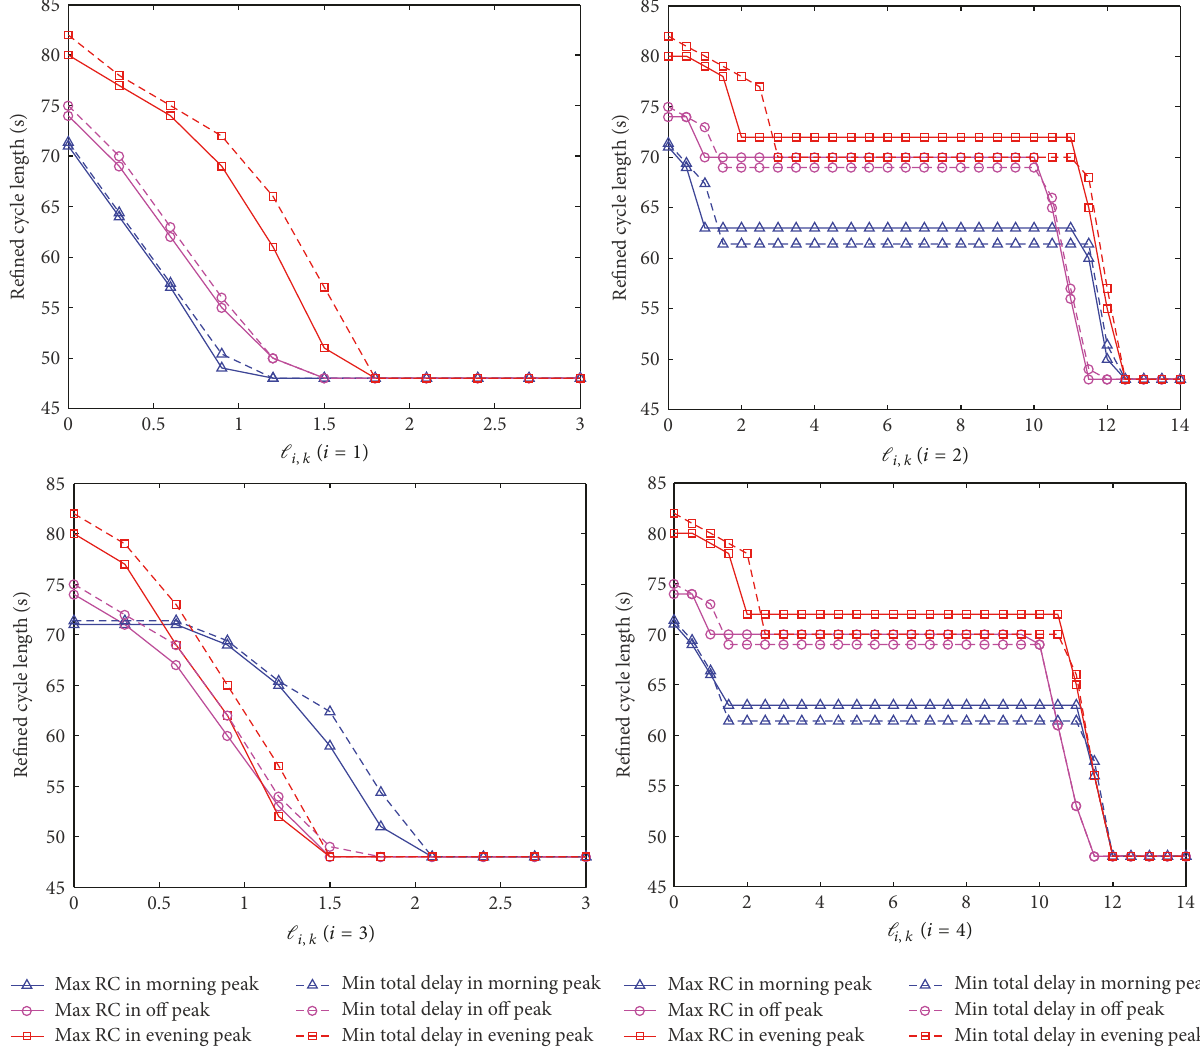
Figure 13: Effects of a single initial queue length, ℓ 𝑖,𝑘 (𝑖 = 1,2,3,4) , in pcu on the refined signal settings.